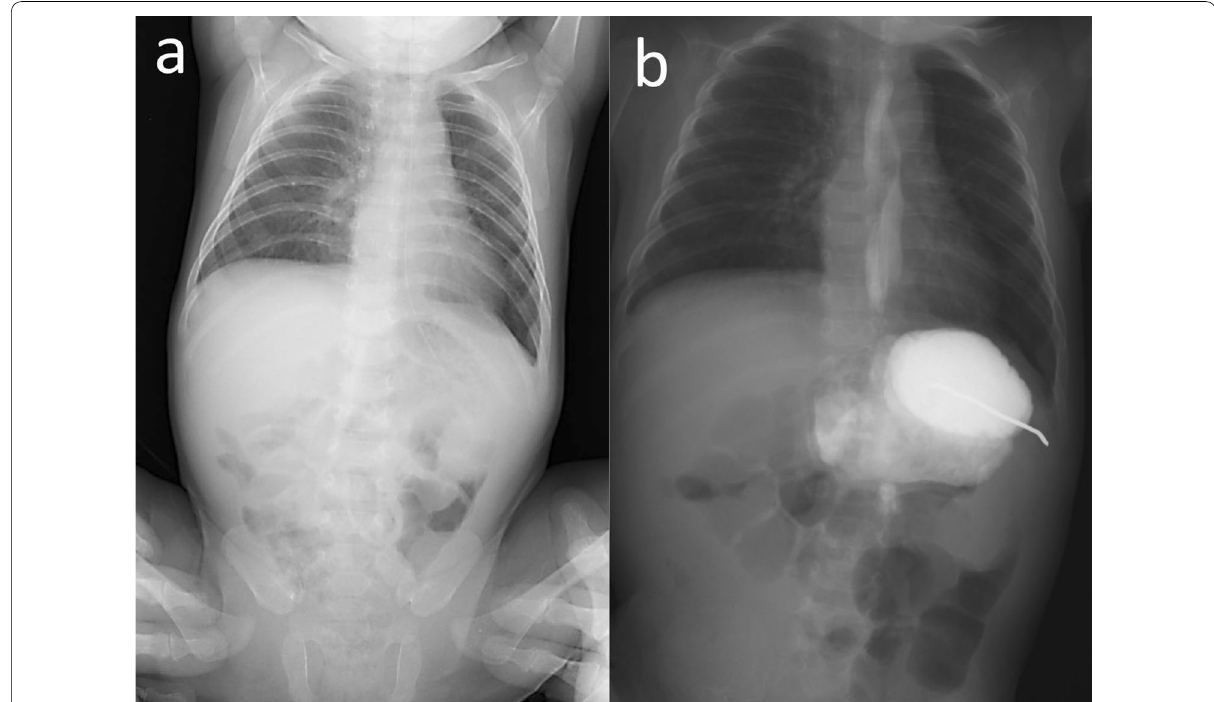
Fig. 3 Postoperative X-ray ( a ) and upper gastrointestinal series ( b ). a Postoperatively, the stomach was correctly positioned without volvulus. b Gastroesophageal reflux persisted for a